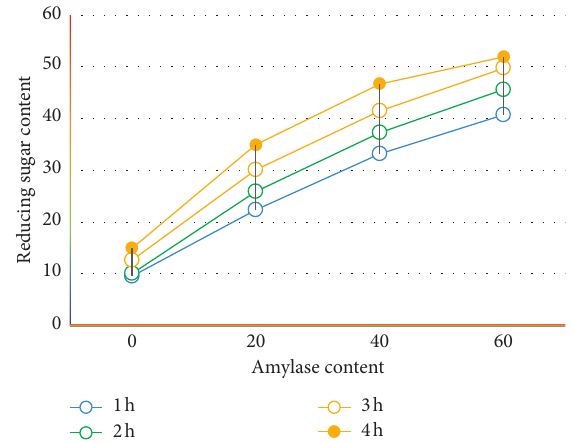
Figure 3: Change of reducing sugar